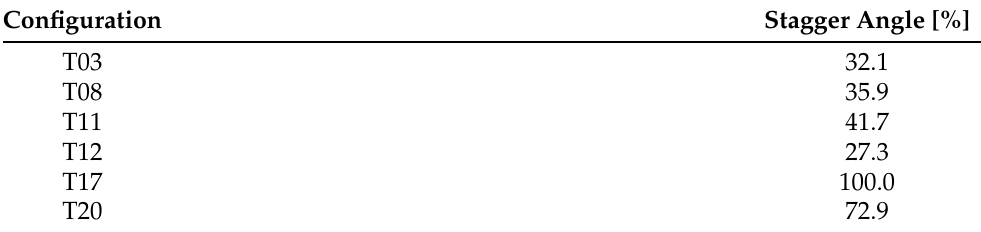
Table 1. IGV positions considered for the partial load compressor